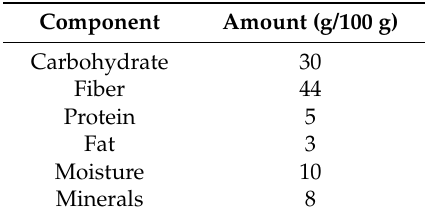
Table 5. Composition of Moringa oleifera leaves.